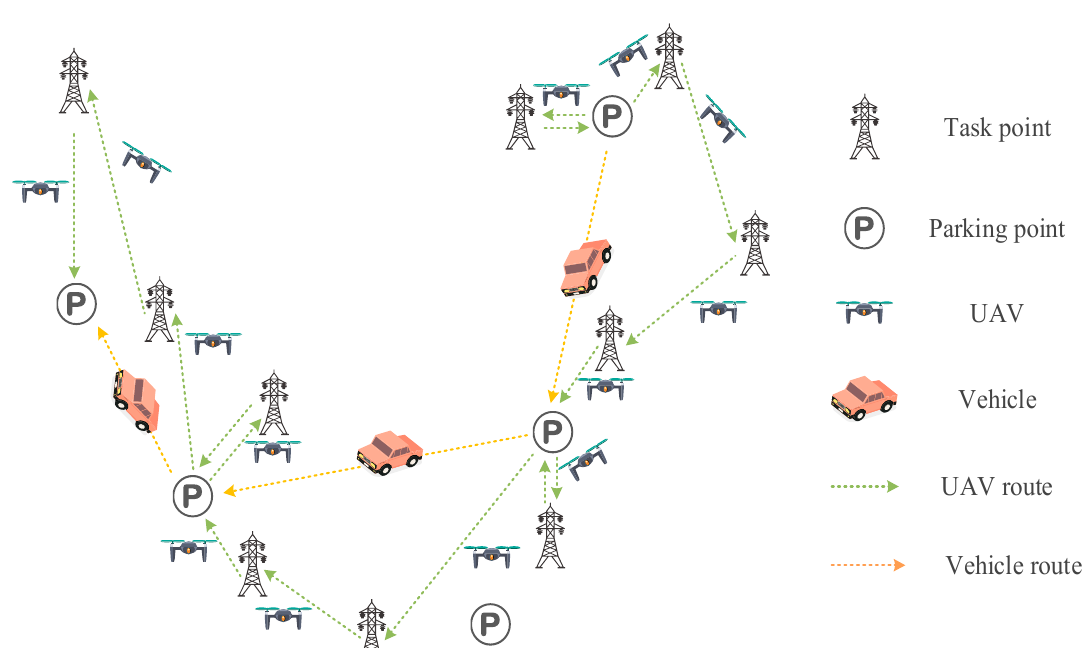
Figure 1. Illustration of the transmission tower inspection traveling salesman problem with drone (TTI-TSP-D).